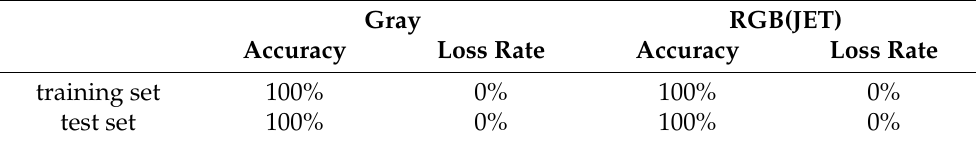
Figure 17. The architecture of the CNN network. Table 4. The classification results of the CNN